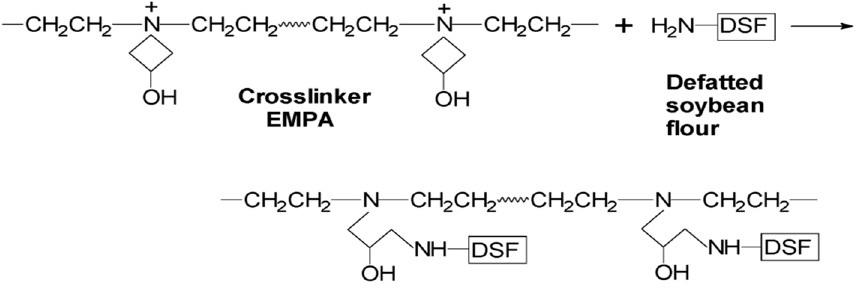
Figure 3. Schematic illustration of the crosslinking reaction between DSF and epichlorohydrin-modified polyamide (EMPA).